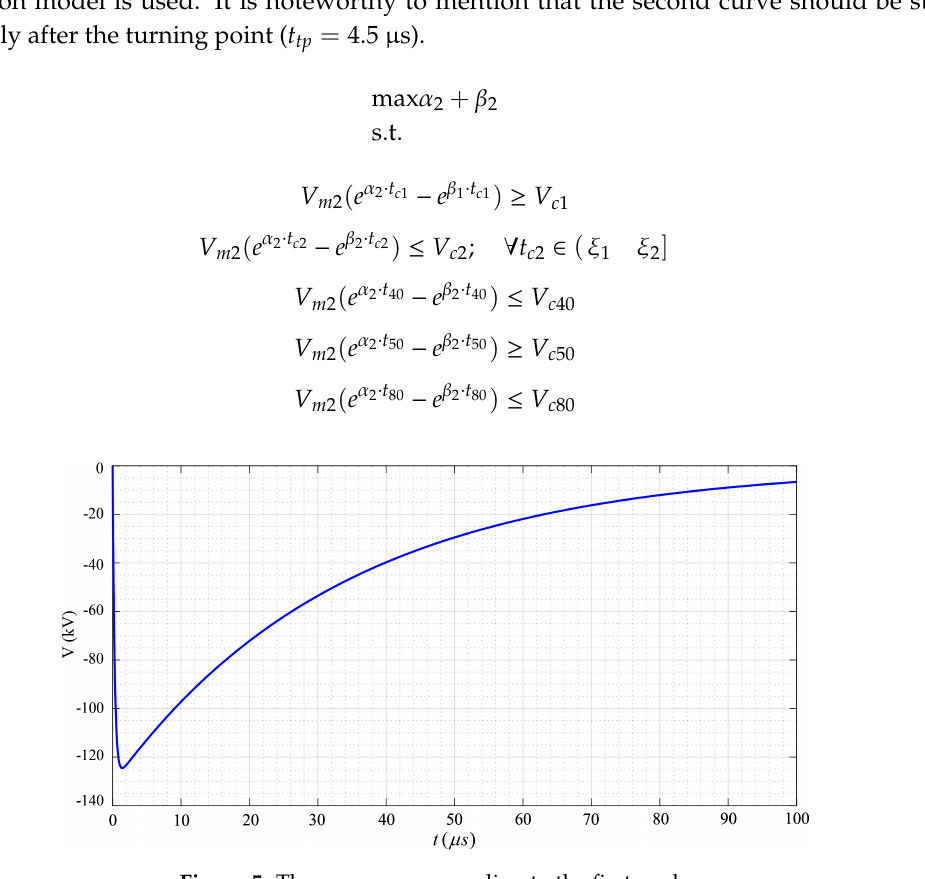
Figure 5. The curve corresponding to the first peak.